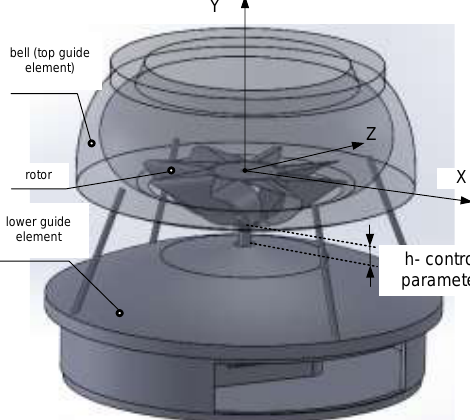
Figure 1. WP construction of optimized bell with rotor. 3.2 Сfd -analysis of the optimal form WP. OXY at a flow rate of V = 10 m / c, angular rotor speed w with the initial bell (2b) and optimized (2c) forms (Fig.